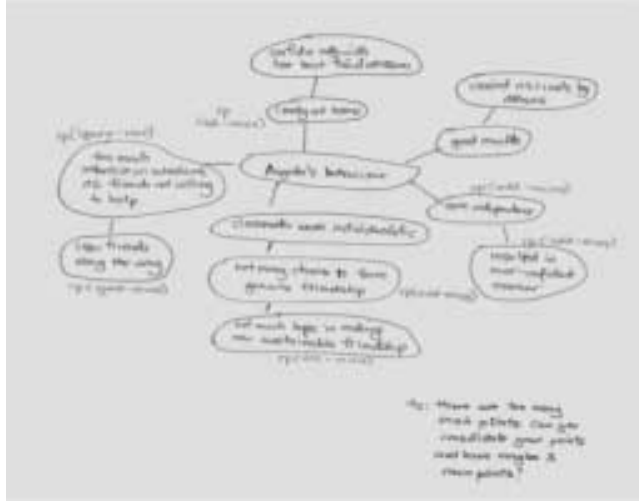
Figure 2. Sample showing a student’s revisions based on peer comments. Note : rp refers to revi- sion based on peers’ comments, and tc refers to teacher comments. Categorizations in parentheses refer to type of revision